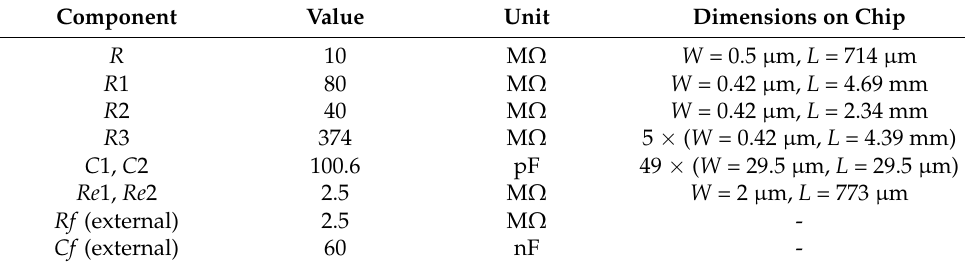
Figure 8. Proposed sensor interface. The values for each passive component of Figure 8 appear in Table 3. Table 3. Passive component characteristics of the integrated